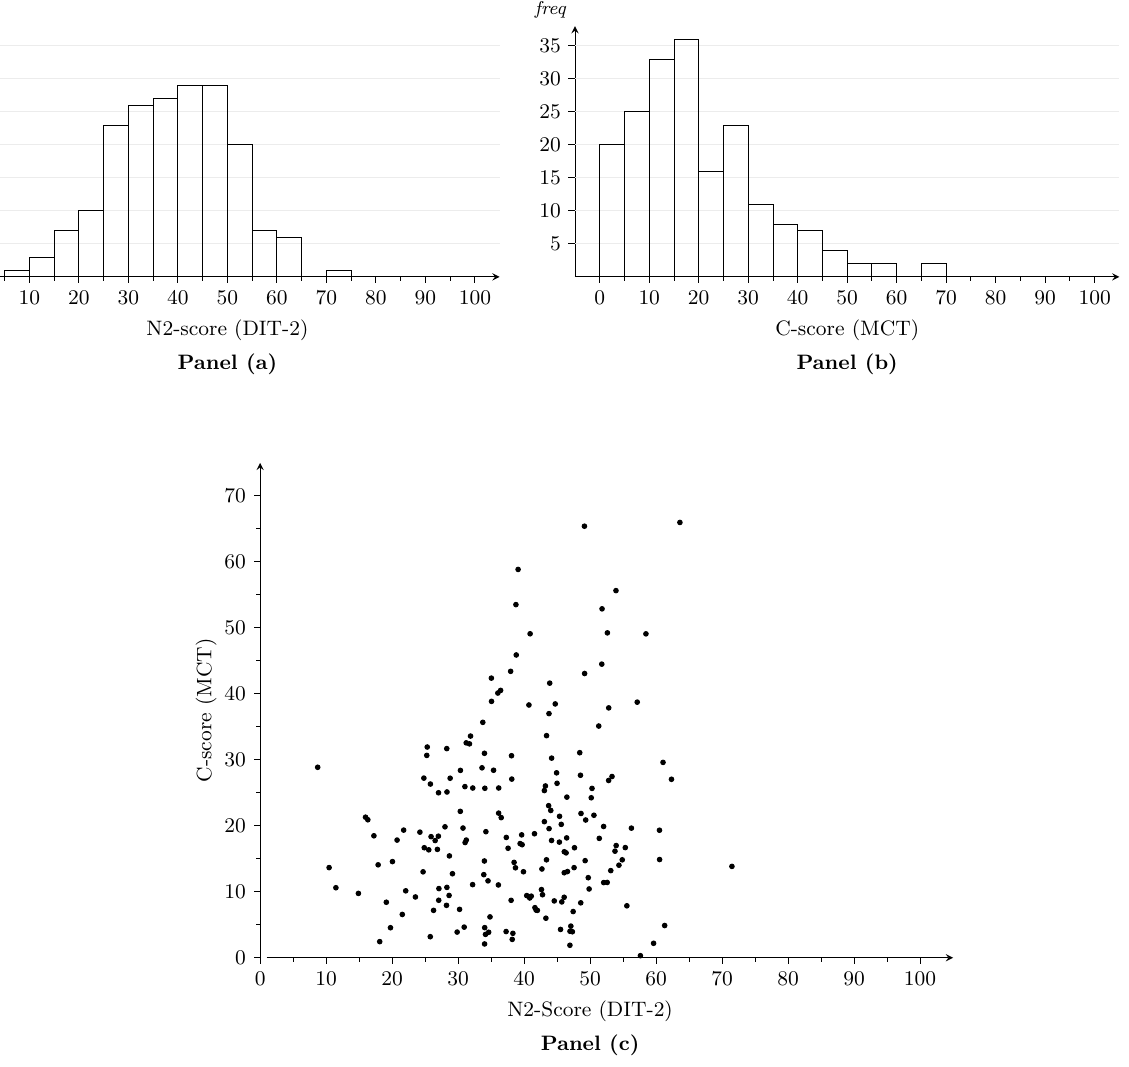
Figure 2. Panel ( a ): distribution of the scores on the N2-index; Panel ( b ): distribution of the C-scores; Panel ( c ): scatter diagram of the scores on the N2-index and C-scores.